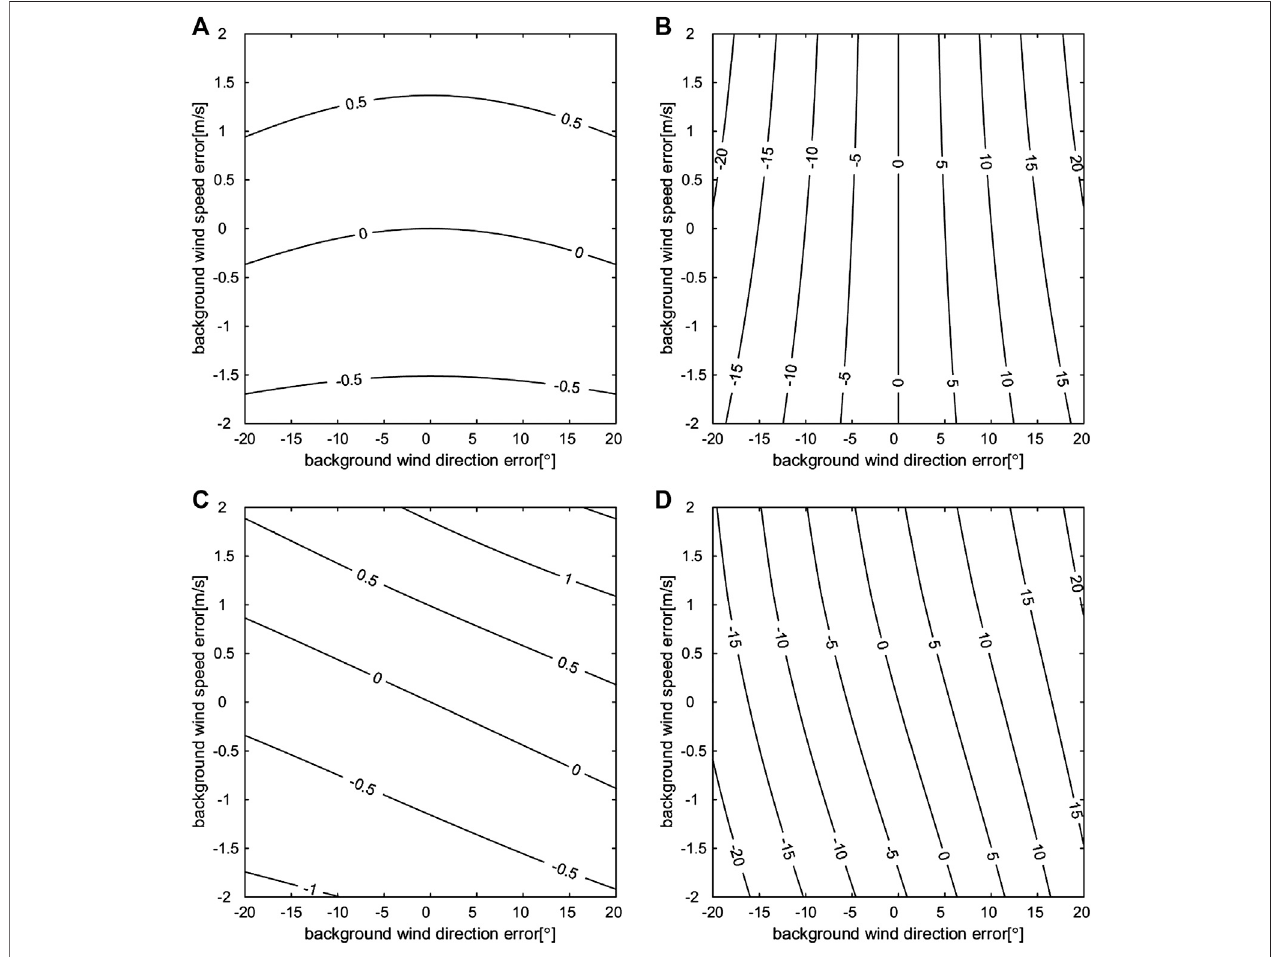
FIGURE 2 | Optimal interpolation (OI)-retrieved wind speed errors (A , C) and wind direction errors (B , D) (the isolines) when the true speed is 5 m/s, and the true wind direction is either 0 ° (A , B) or 45 ° (C , D) ; the background wind speed errors (Y axis) and the background wind direction errors (X axis) are given.